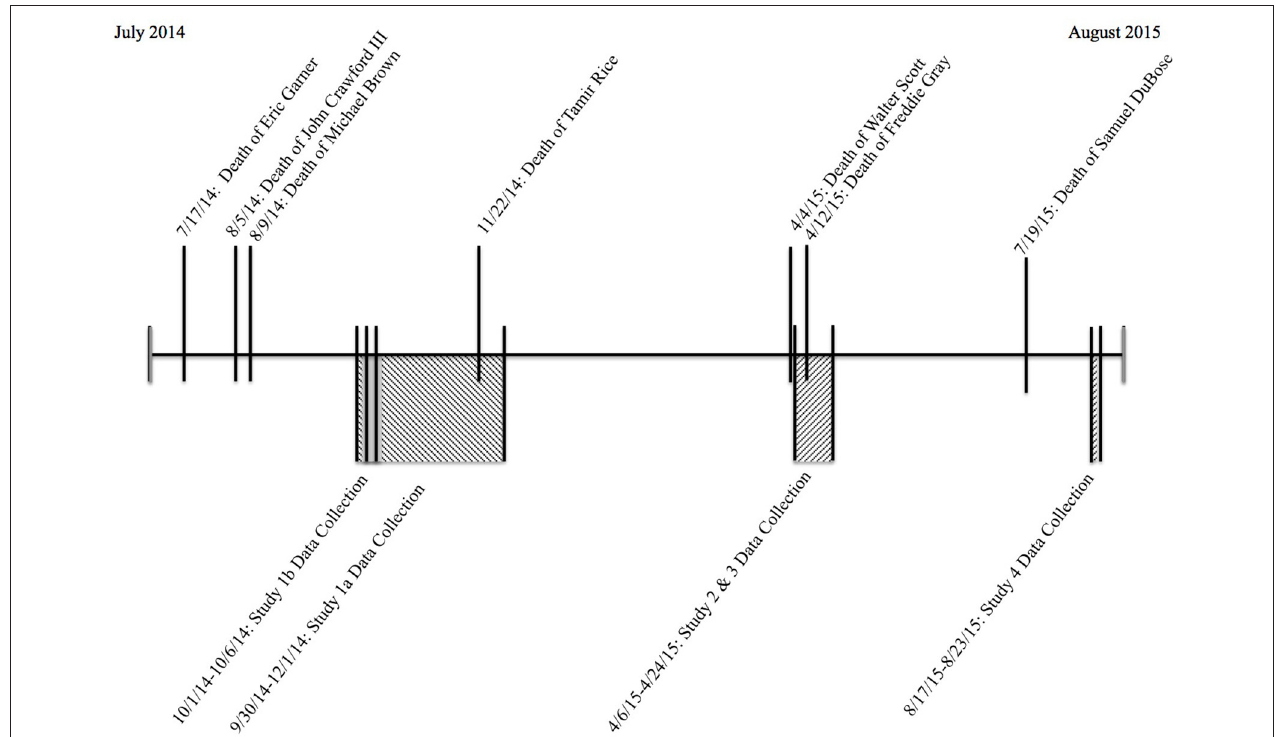
FIGURE 3 | Timeline of data collection for all studies within the context of critical events related to the policing policy reform debate.